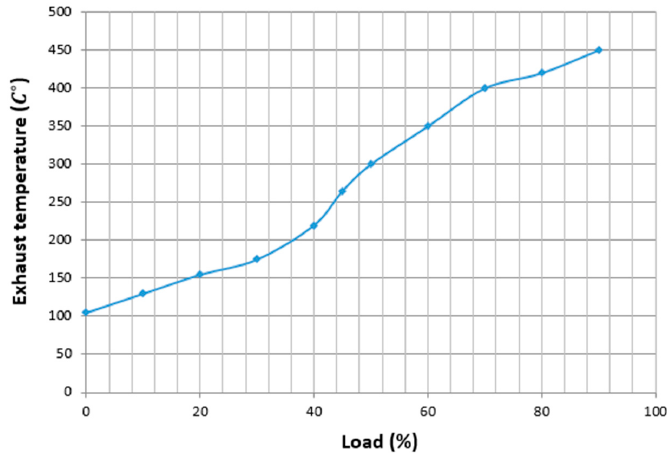
Figure 3. Relationship between %load and exhaust temperature.